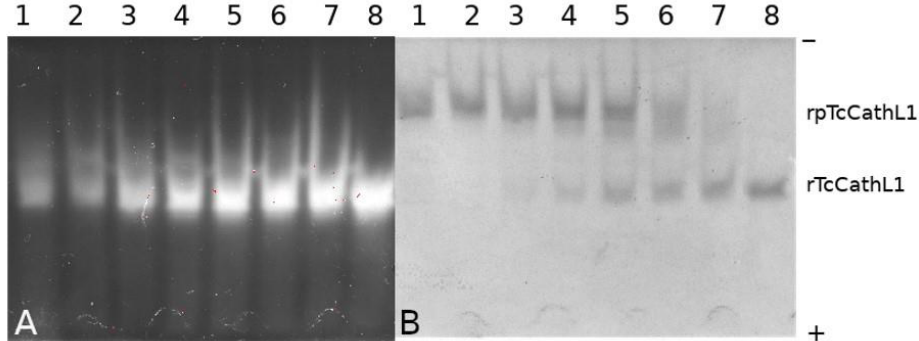
Figure 3. Native PAGE of rpTcCathL1 processing products during incubation from 0 to 60 min; the proenzyme concentration was 0.12 mg/mL. ( A ) Lanes 1–8: post-electrophoretic activity testing with 75 µM fluorogenic substrate Glp-Phe-Ala-AMC of rpTcCathL1 processing products after 0, 5, 10, 15, 20, 30, 40, and 60 min of processing; ( B ) lanes 1–8 rpTcCathL1 processing products after 0, 5, 10, 15, 20, 30, 40, and 60 min of processing stained with Coomassie G-250 after activity testing.